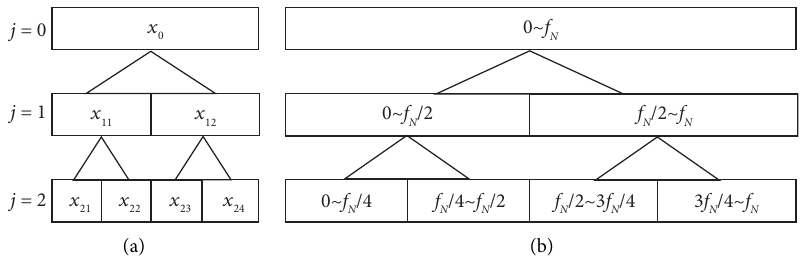
Figure 5: Principle of WPT. (a) WPT of signal. (b) Frequency band of WPT.